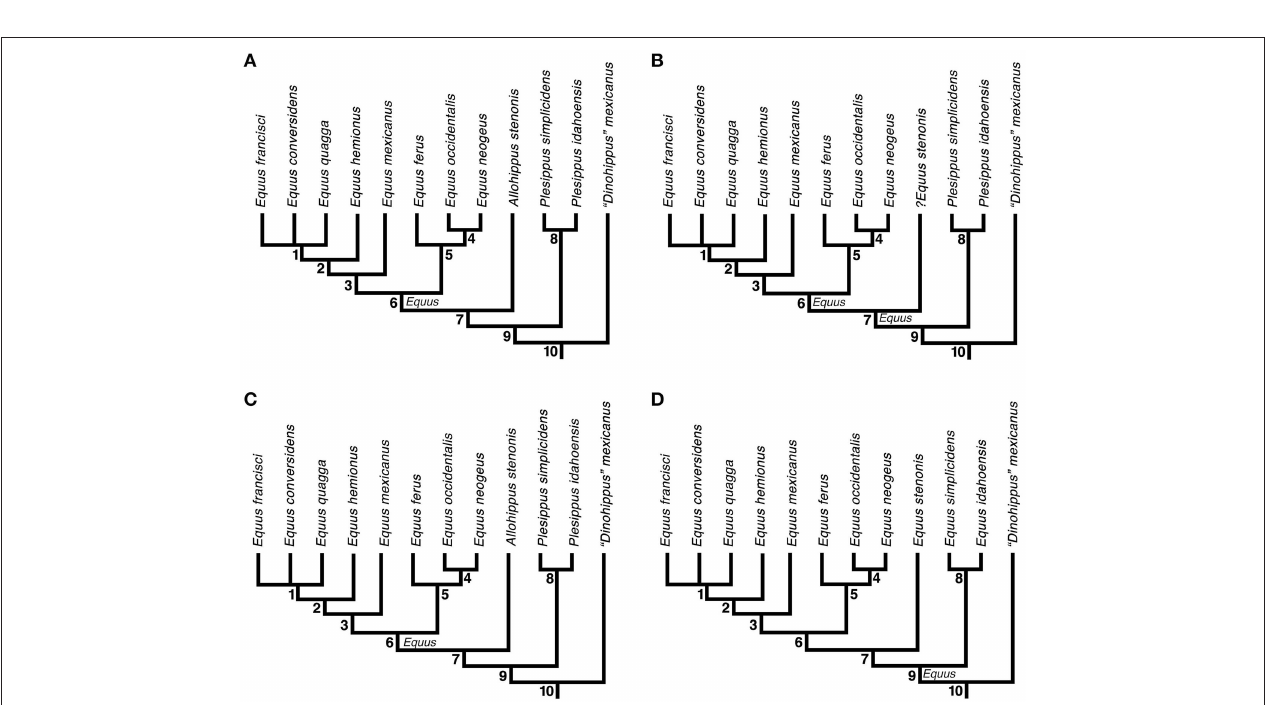
FIGURE 2 | Taxonomic position of Equus in the strict consensus tree ( Figure 1 ) based on four explicit criteria (in addition to monophyly) previously used to delimit mammalian genera: phylogenetic gaps (A) , uniqueness of adaptive zone (B) , crown group definition (C) , and divergence time (D) .